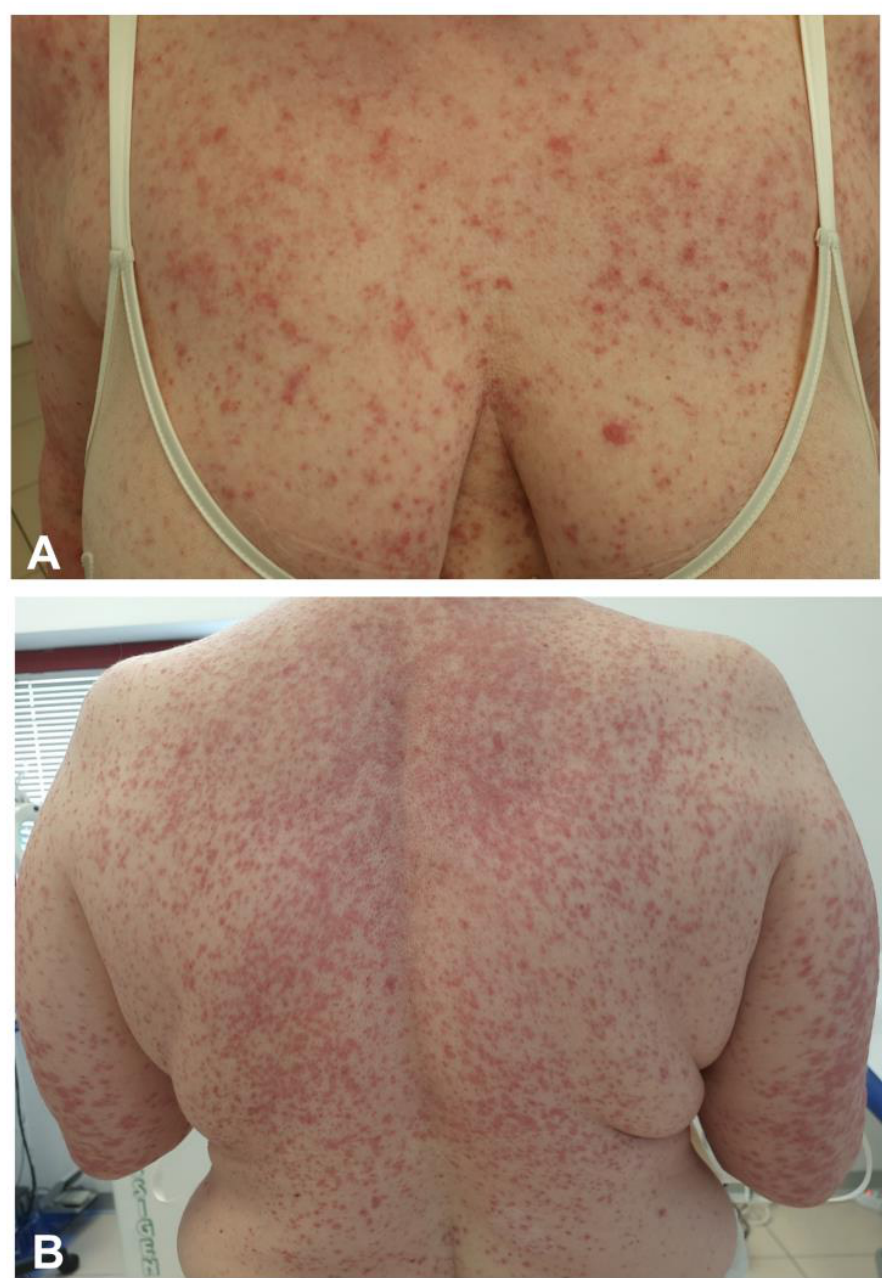
Figure 3. Itchy confluent erythematous maculopapular eruption involving the upper trunk and limbs in a bilateral and symmetrical fashion and typical craniocaudal progression developed five days after the mRNA-1273 vaccine on a 54-year-old woman ( A , B ).